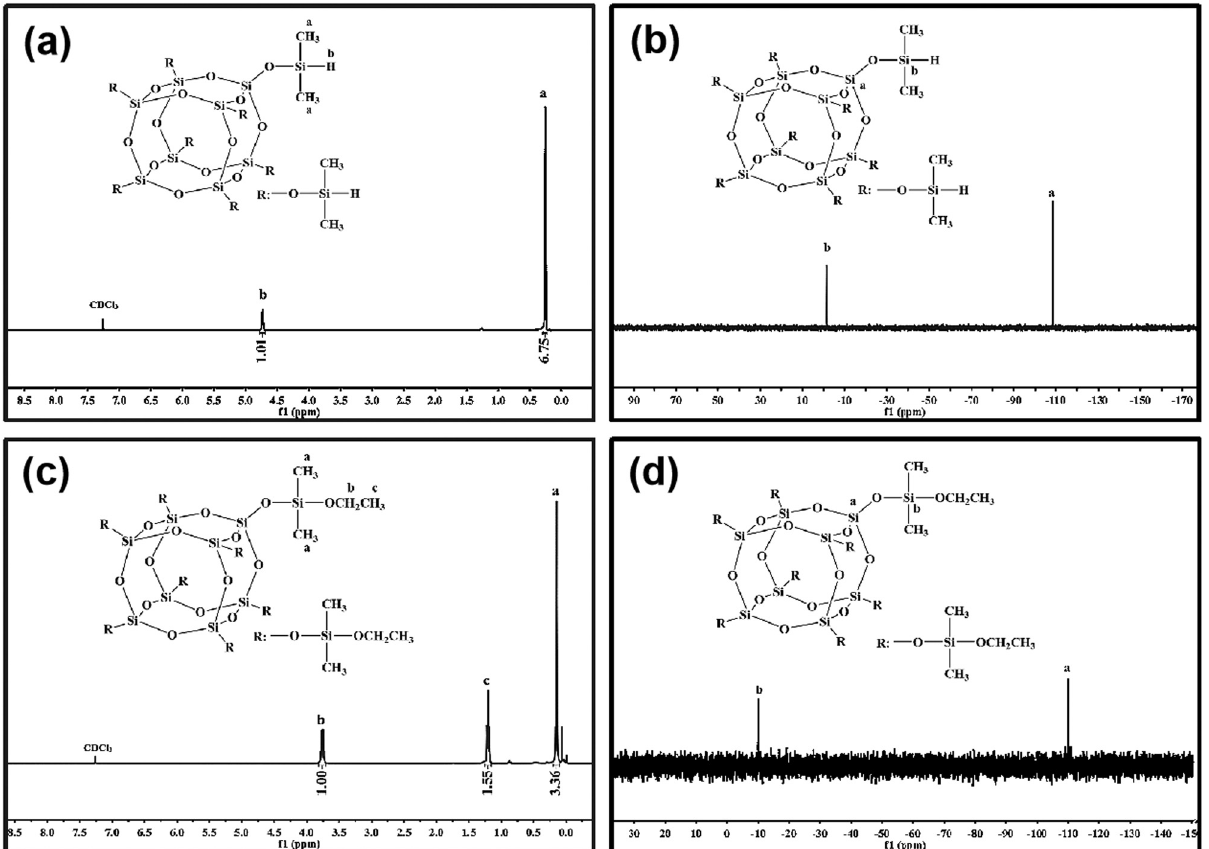
Figure 1: 1 HNMR spectra of ( a ) ODHS and ( c ) ODES, and 29 SiNMR spectra of ( b ) ODHS and ( d ) ODES.